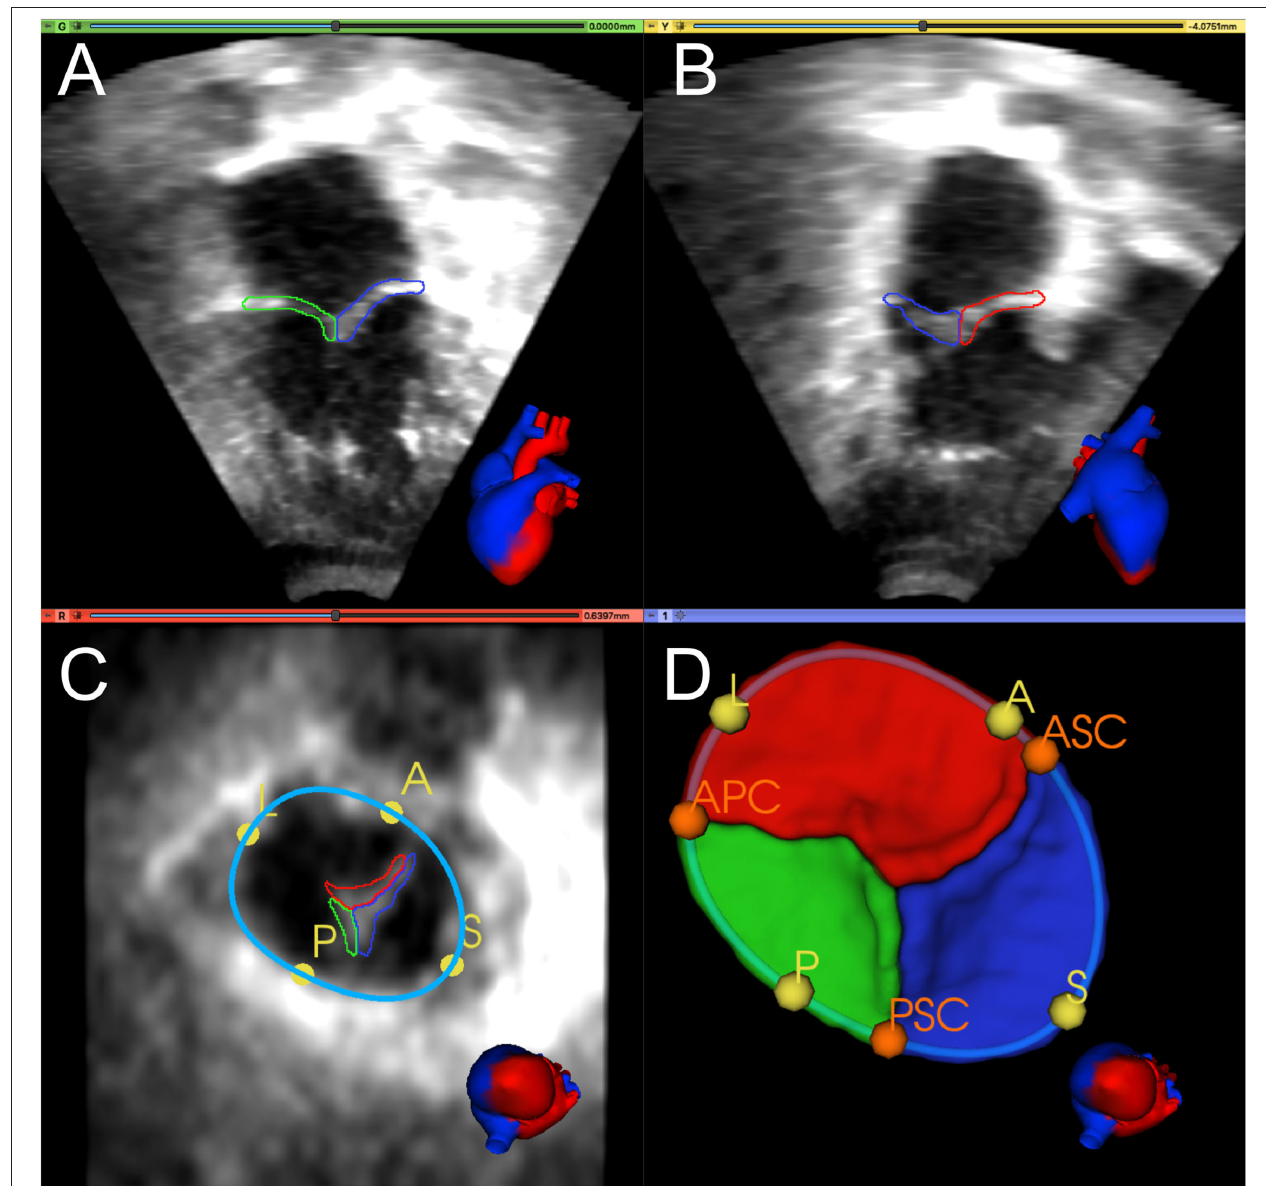
FIGURE 1 | Manual segmentation and annotation of the tricuspid annulus and leaflets. (A) Apical 4-chamber view of 3D TTE MS frame showing the posterior (green) and septal (blue) leaflet; (B) Apical 2-chamber view of 3D TTE MS frame showing the anterior (red) and septal (blue) leaflet. (C) Ventricular view of 3D TTE MS frame with all three leaflets, the annular curve (light blue), and the quadrant landmarks (yellow): anterior (A), posterior (P), septal (S), and lateral (L). (D) 3D model of the segmented TV and the annular curve with APSL quadrant landmarks (yellow) and commissural landmarks (orange): anterior-septal commissure (ASC), posterior-septal commissure (PSC), and anterior-posterior commissure (APC). A heart avatar (red = left heart and aorta, blue = right heart, inferior and superior vena cava) is also provided for orientation of the echocardiographic